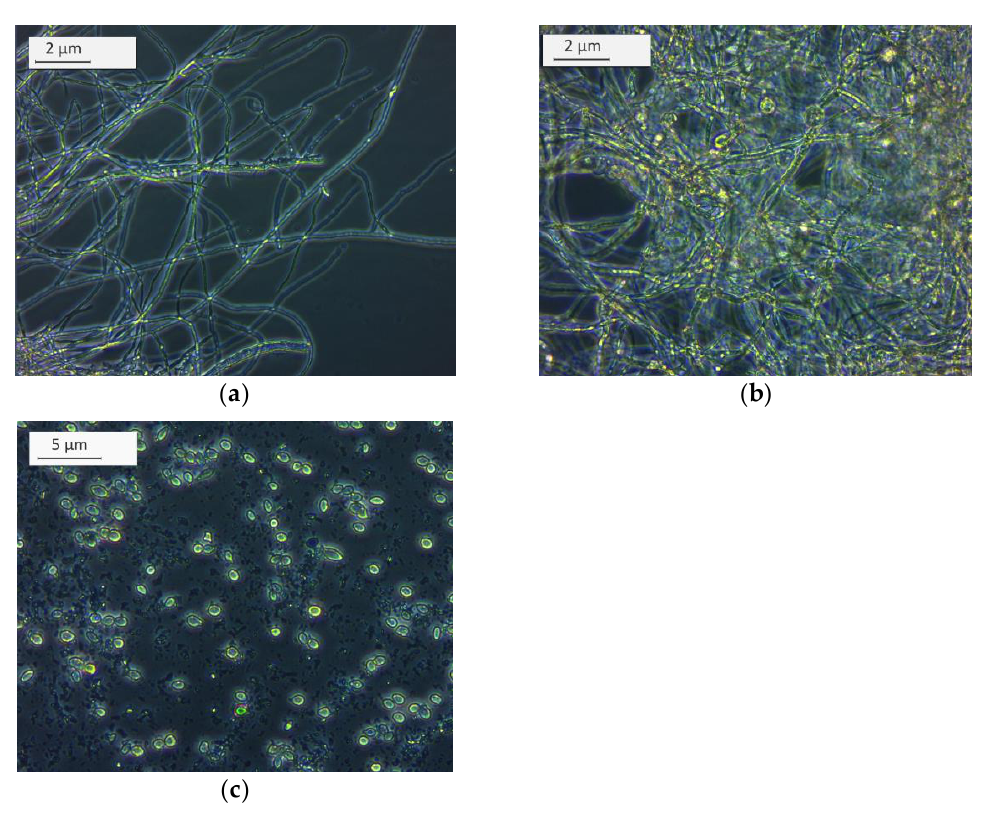
Figure 6. Optical microscopy images (100×) of P. chrysosporium filamentous hyphae network formed under submerged culture ( a , b ), as compared to the sporangium cells’ morphology when grown onto potato dextrose agar (PDA) ( c ).